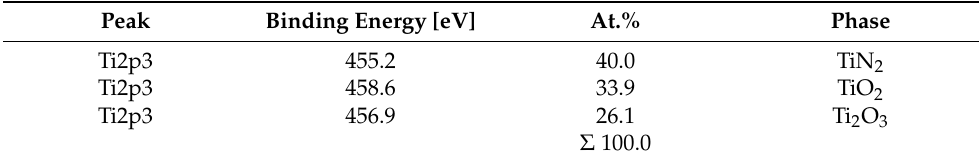
Table 3. Binding energy peaks and the corresponding phase composition of the composite titanium nitride layers’ surface subjected to hydrothermal treatment in overheated steam (XPS). Normal- ized results.